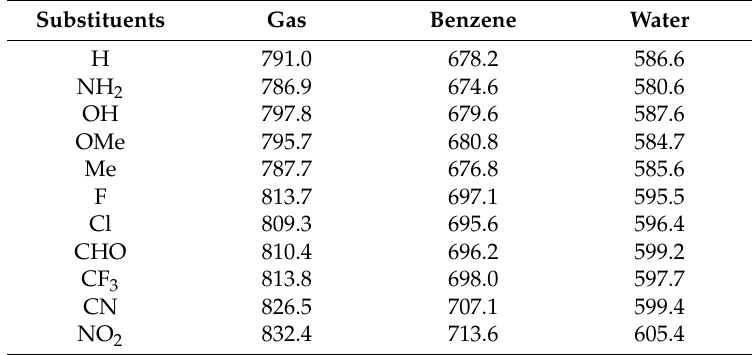
Table 2. Ionization potential (IP) in kJ/mol obtained by the M062X/6-311+G ** method. Substituents Gas Benzene Water H